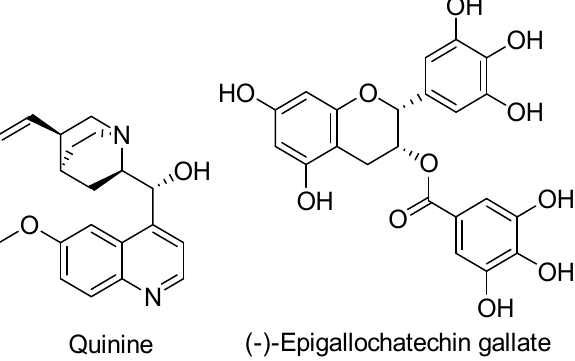
Figure 21. Structure of quinine and (-)-epigallocatechin gallate (EGCG). The mechanism of host cell invasion and adhesion by pathogenic bacteria are often related. Inhibitors of the internalization process will potentially be adhesion inhibitors and vice versa. EGCG (Figure 21) has been shown to inhibit T3SS-mediated adhesion and internalization of multiple organisms including EPEC and EHEC, S. Typhimurium, and Y. pestis [251,252]. EGCG was analyzed for its ability to inhibit adherence of EPEC to human epithelial type 2 (Hep-2) cells. In this assay, EPEC was cultured with the Hep-2 cells and incubated for 2 h in the presence and absence of EGCG. The Hep-2 cells were then affixed to a microscope slide and stained with Giemsa to determine the number of adhered bacteria. EGCG at concentrations of 100 µ M reduced adherence by ~50% [251]. Tsou et al. evaluated EGCG’s ability to inhibit S . Typhimurium invasion into HeLa cells via